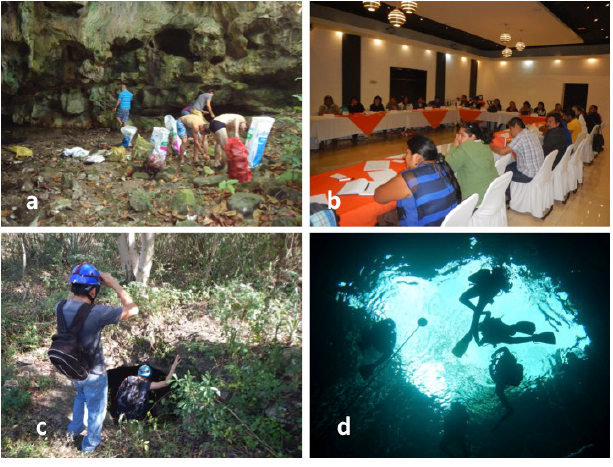
Fig. 5 . Example of some of the activities performed during the project, (a) cenote clean-ups with community members, (b) workshops with members of the ECA, and (c) speleological and (d) underwater exploration (Photos: Lopez,